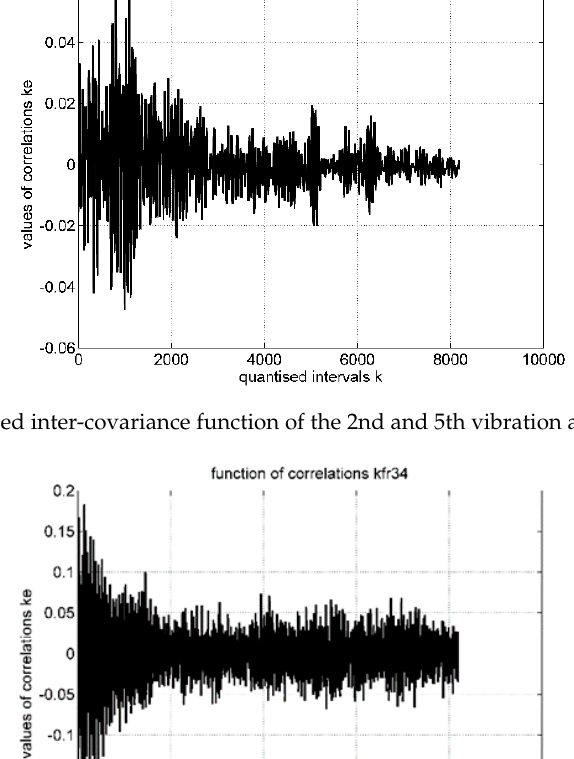
Figure 9. Normalized inter-covariance function of the 1st and 6th vibration accelerations vectors.